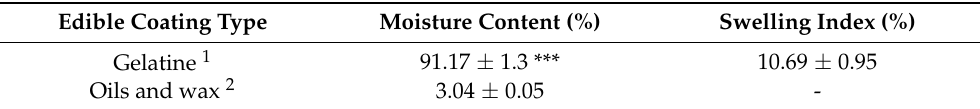
Table 1. Moisture content (%) and swelling index (%) of the gelatine coating and the combination coating using oils and